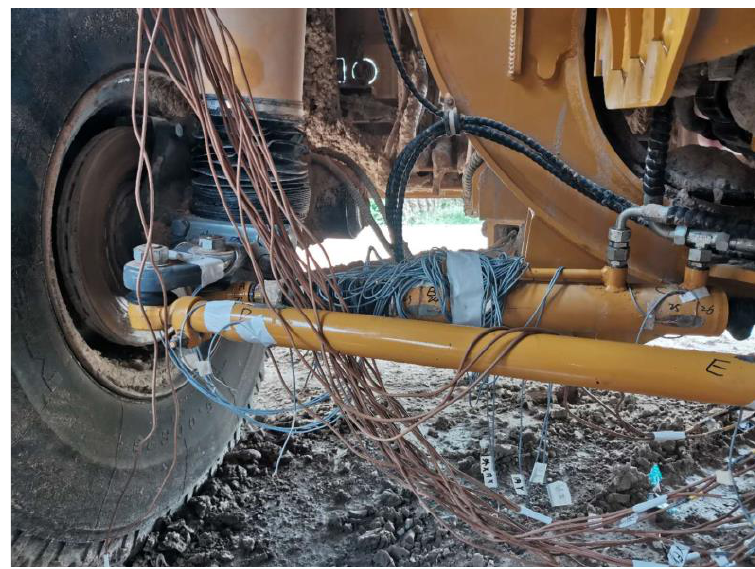
Figure 10. Stress test of the front axle system.